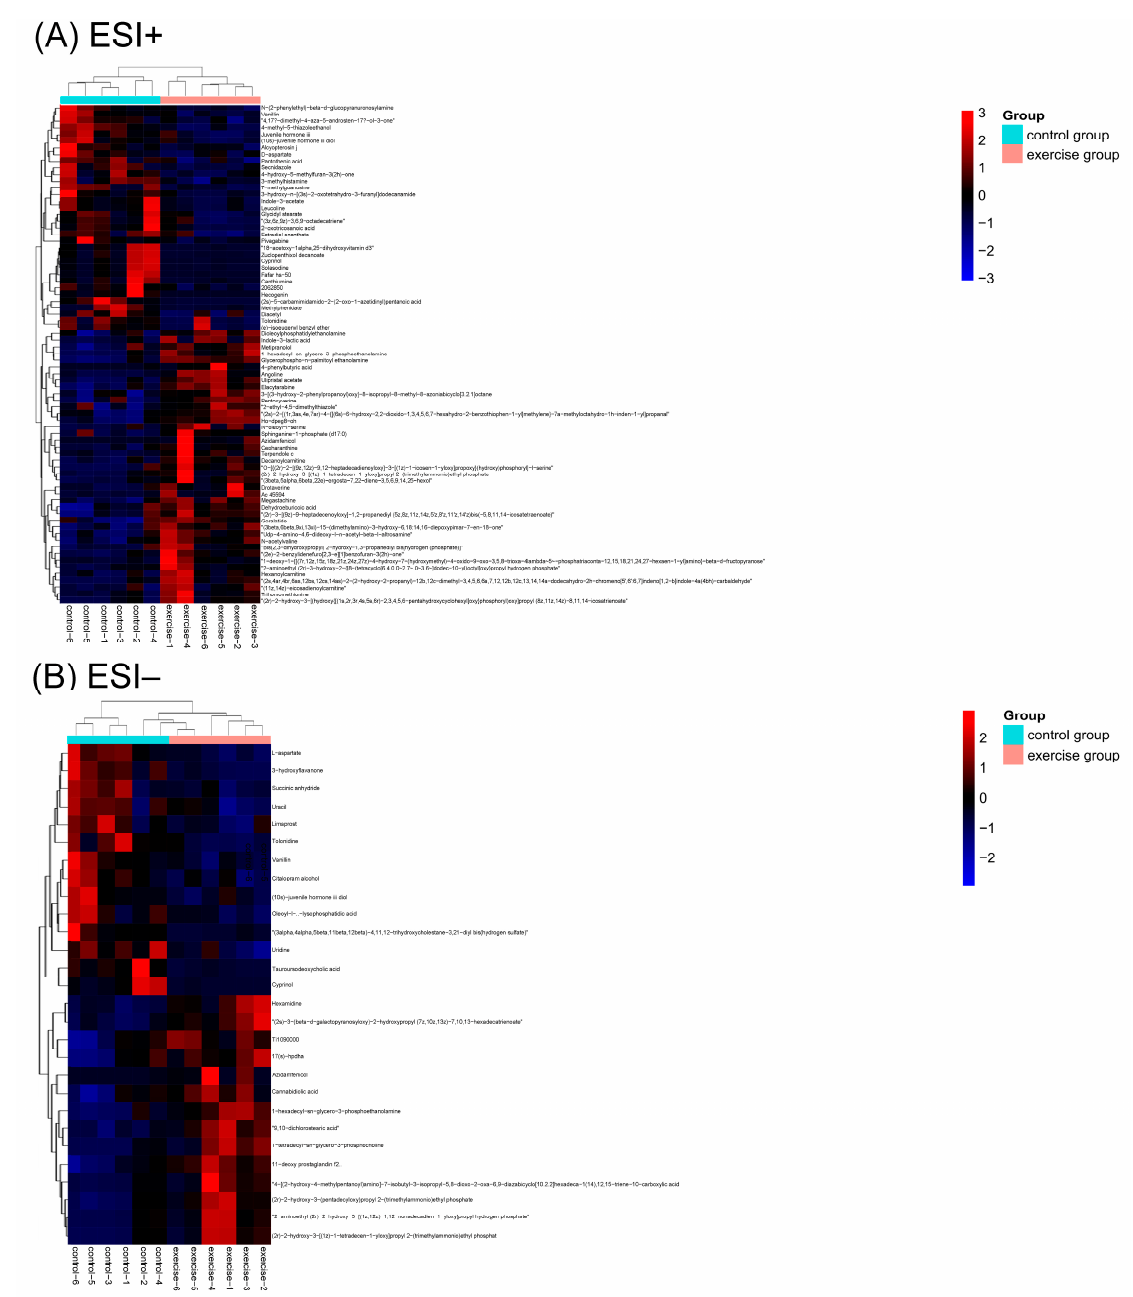
Figure 4. Heat map of the differential metabolites (DMs) in the positive electron spray ionization (ESI+) and negative electron spray ionization (ESI − ) modes ( A , B ). Red color represents relative increase in abundance, and blue color represents relative decreases in abundance. Color codes are indicated in the color bar on the right